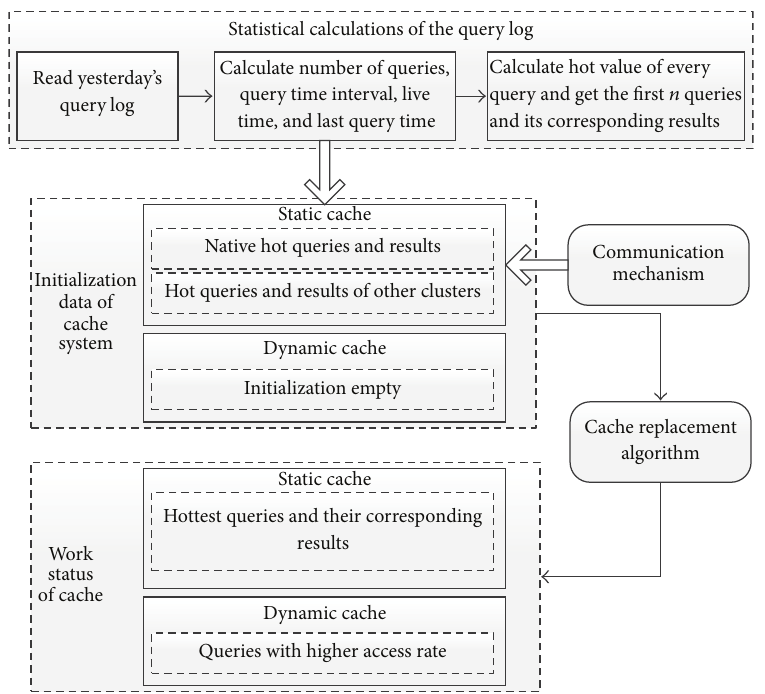
Figure 2: Distribution strategy of static cache and dynamic cache